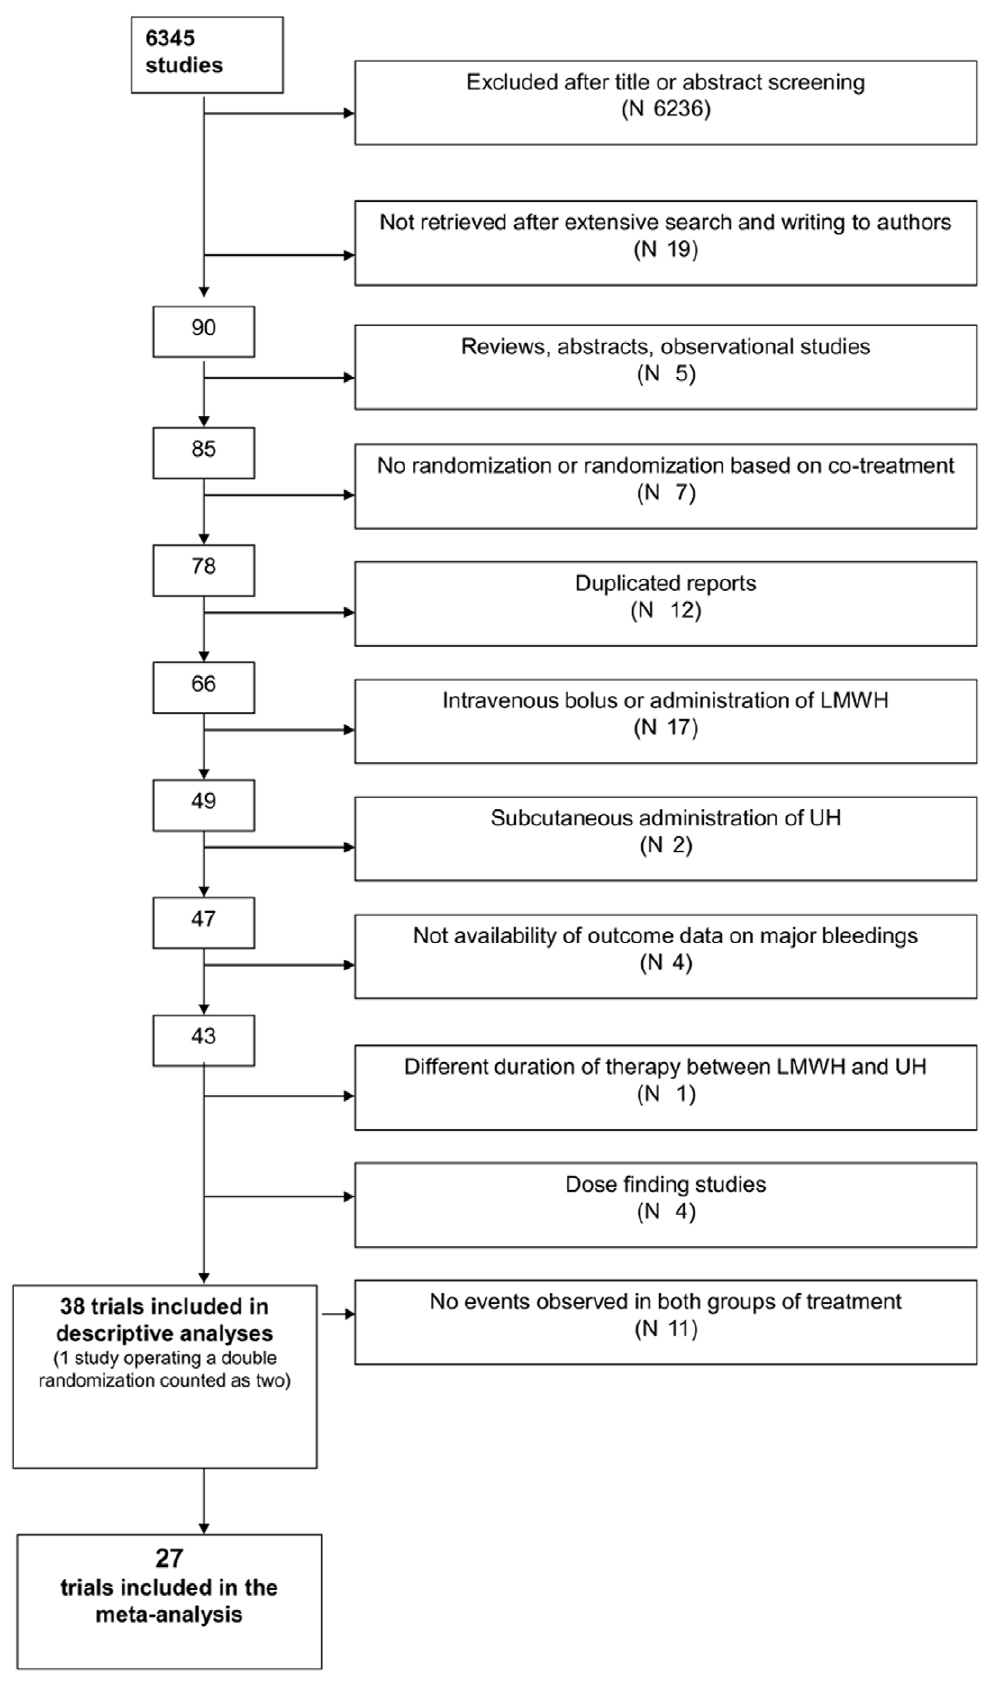
Figure 1. Study selection progression. doi:10.1371/journal.pone.0044553.g001 PLOS ONE | www.plosone.org